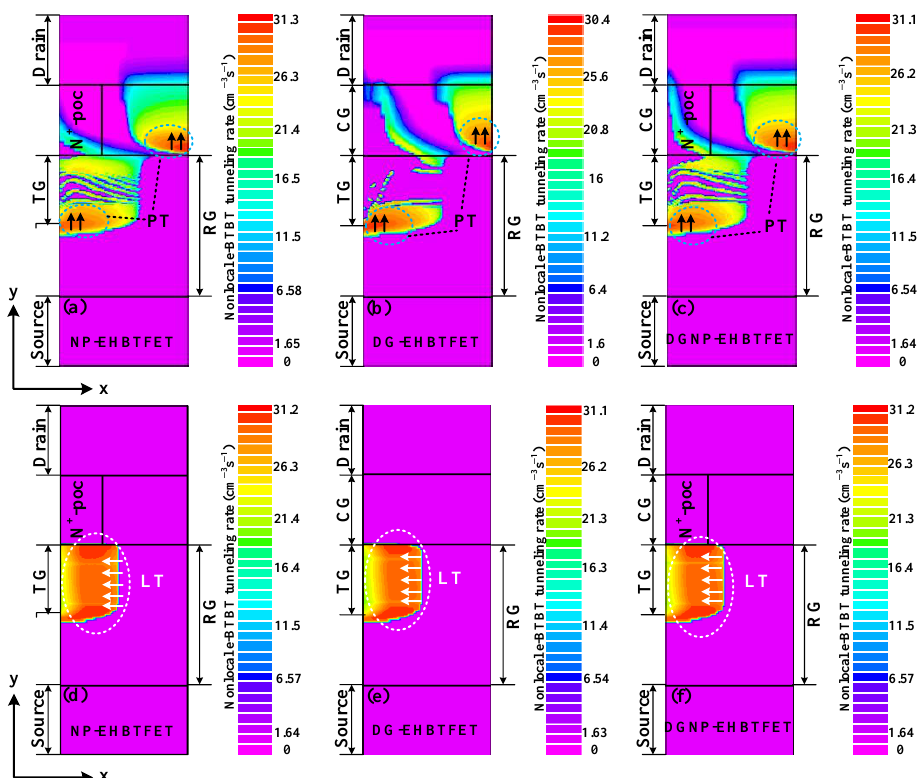
Figure 3. Contour plots of the vertical non-local e-BTBT tunneling rate for ( a ) NP-EHBTFET; ( b ) DG- EHBTFET; and ( c ) DGNP-EHBTFET, in the ON-state. Contour plots of the lateral non-local e-BTBT tunneling rate for ( d ) NP-EHBTFET; ( e ) DG-EHBTFET; and ( f ) DGNP-EHBTFET, in the